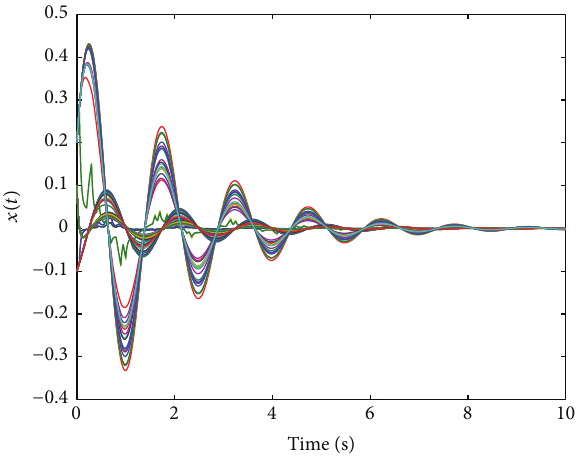
Figure 11: Simulation of the closed-loop